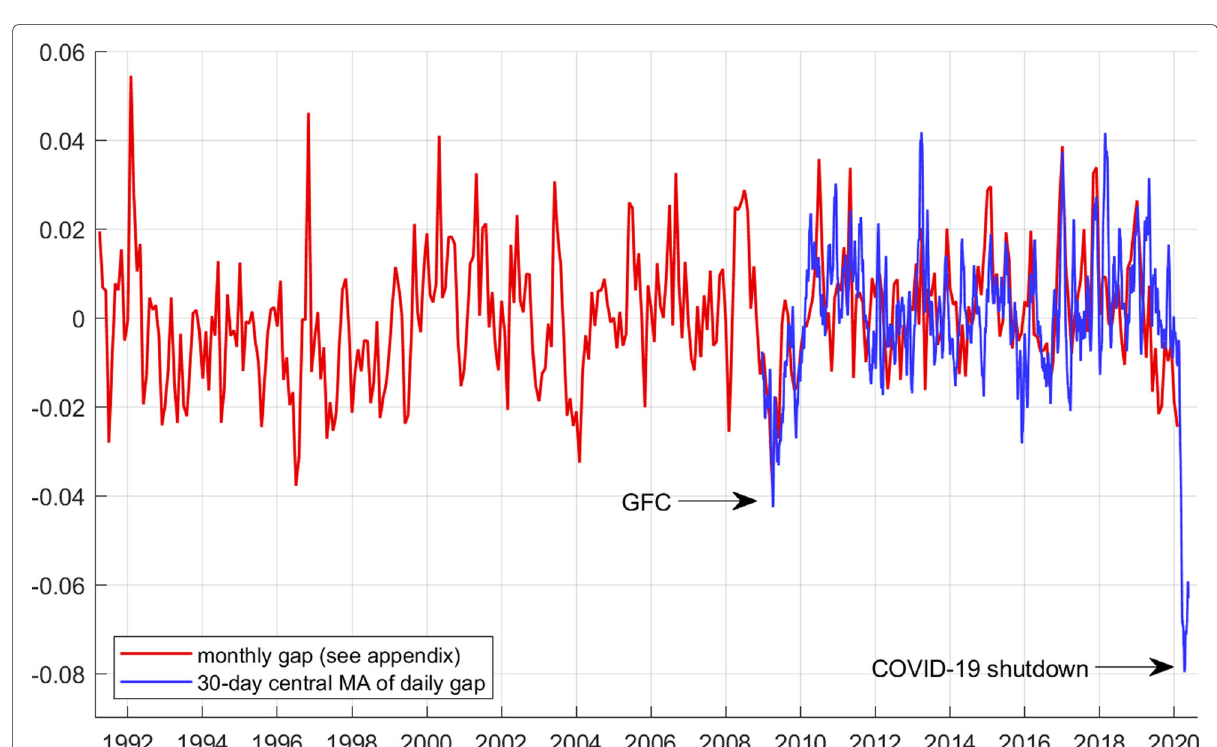
Fig. 5 Monthly gap ( g ) in red, April 1991 to December 2019, and 30-day moving average of the daily gap in blue, January 2009 to May